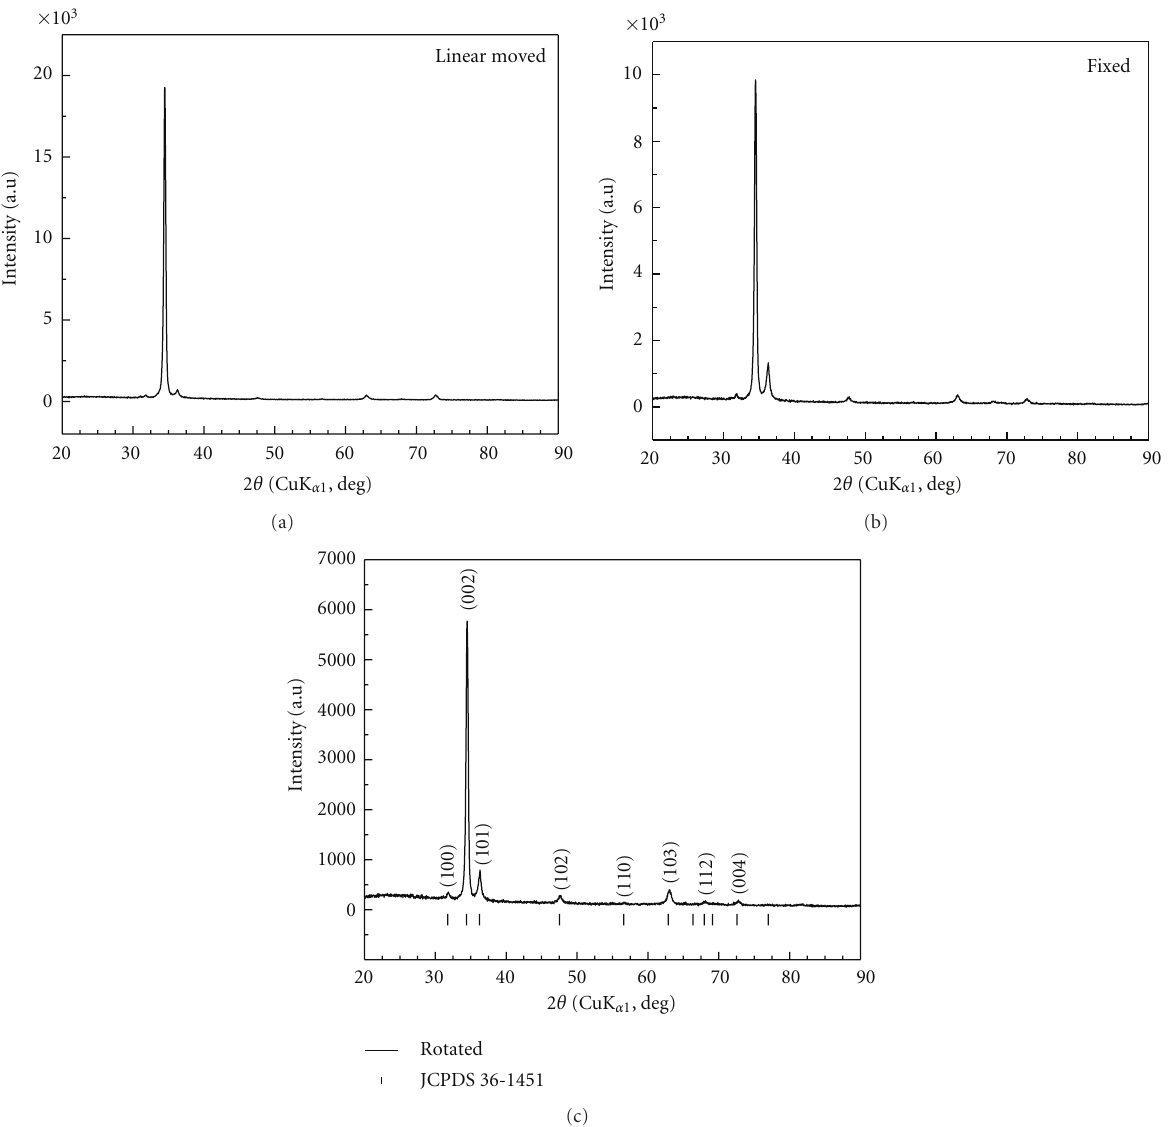
Figure 4: X-ray di ff raction patterns of ZnO thin films, (a) on the linear moved substrate at the horizontal axis, (b) on the fixed substrate, and (c) on the rotated substrate in the horizontal plane, and “ | ” symbol indicates the reference (JCPDS 36-1451).